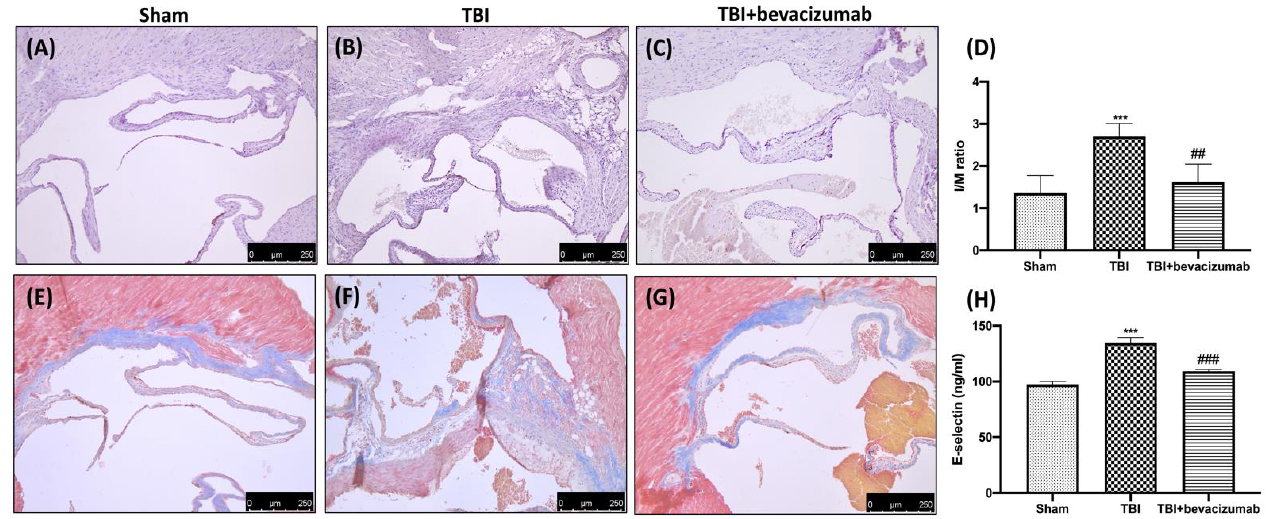
Figure 8. Effects of bevacizumab on E-selectin and atherosclerosis. Representative images of Sham ( A ), TBI ( B ) and TBI+bevacizumab ( C ) and quantification of lesion area normalized by the respective medial area of the aorta at aortic root stained with H&E ( D ) 6 weeks following TBI. Fibrosis evaluation (Masson’s trichrome stain): Sham ( E ), TBI ( F ), and TBI+bevacizumab ( G ). Plasma soluble E-selectin levels were measured 6 weeks following TBI by ELISA kit. Results show a significantly increased level of E-selectin in plasma of TBI mice compared with Sham mice. Bevacizumab treatment significantly restored the levels of E-selectin ( H ). Data are expressed as mean ± SD from n = 5 mice/group. *** p < 0.001 vs. Sham; ## p < 0.01 and ### p < 0.001 vs. TBI.